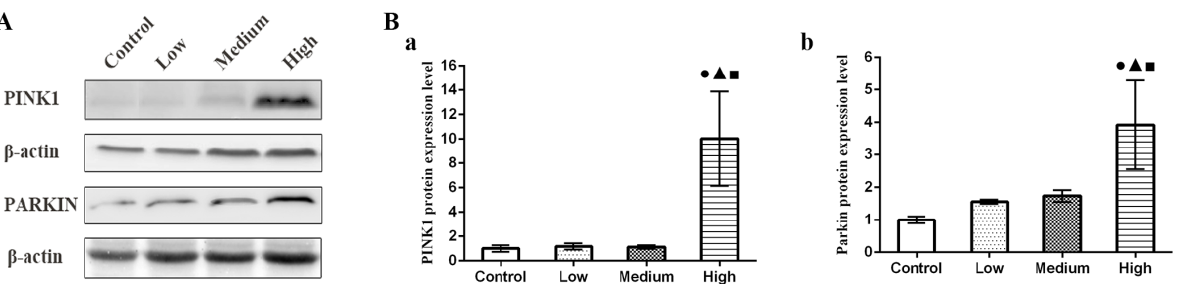
Figure 7. Changes of PINK1 and Parkin protein expression levels in rat lung tissue. ( A ) The expression of PINK1 and parkin proteins in rat lung was detected by Western blot. ( Ba ) PINK1 protein expression level. ( Bb ) Parkin protein expression level. Note: ● , compared with the control group, p < 0.05; ▲ , compared with the low group, p < 0.05; ■ , compared with the medium group, p < 0.05.